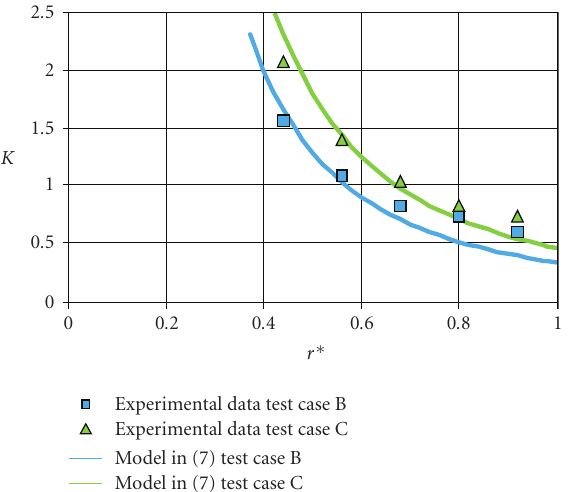
Figure 6: Core swirl ratio distribution.